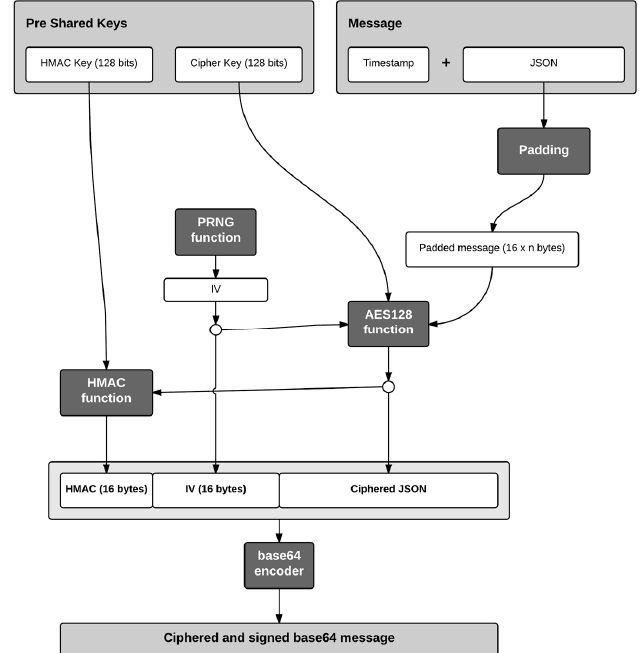
Figure 7. Generation of the encrypted message.